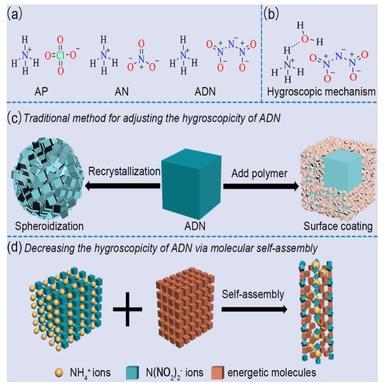
(a) The chemical structures of typical energetic ammonium salt. (b)The hygroscopic mechanism of ADN. (c) Traditional method for adjusting the hygroscopicity of ADN. (d) Decreasing the hygroscopicity of ADN via molecular self-assembly.